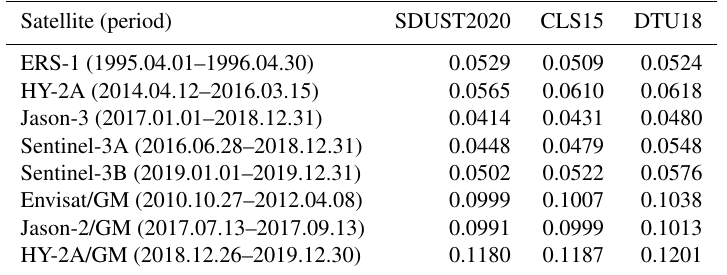
Table 8. SDs of the sea surface height differences of the models SDUST2020, CLS15, and DTU18 compared with satellite altimetry data (unit: m).